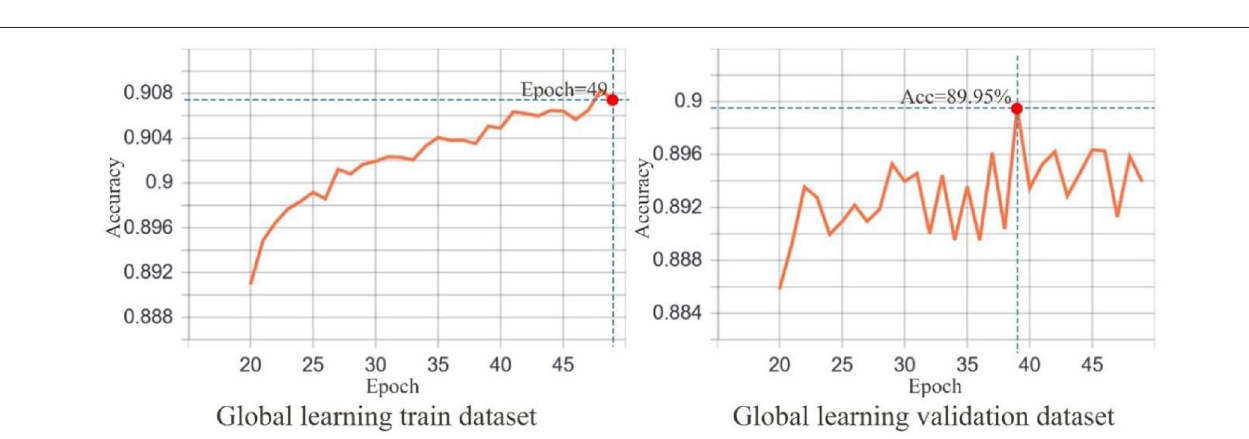
FIGURE 7 | Global learning training accuracy. The number of epochs was set at 60. The graph on the left presents early stopping at epoch 49. The graph on the right shows a maximum accuracy of